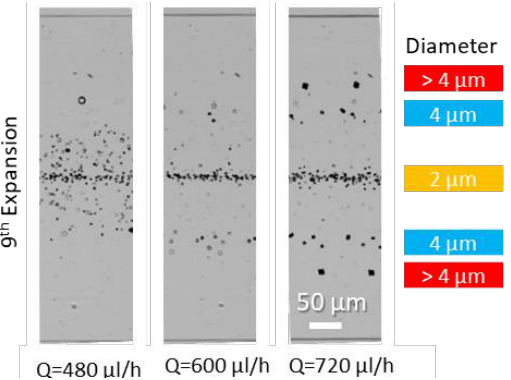
Fig. 2. Image stacks of 2 and 4µm PS bead mixture suspended in 9000 ppm PBS/PEO 600kDa at 480, 600, and 720 µL/h flow rates.